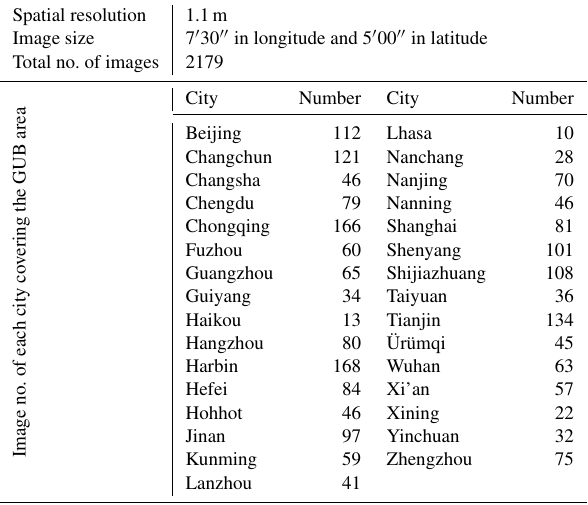
Table 2. Statistical description of the Google Earth imagery. Spatial